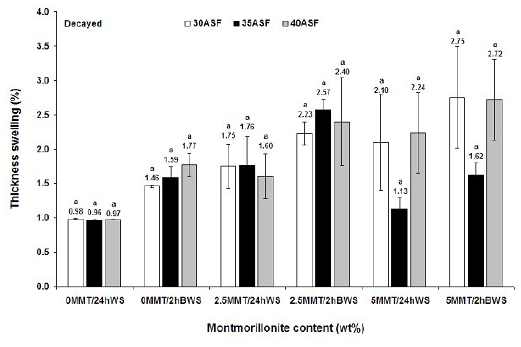
Figure 7. The average and standard error for thickness swelling measurements (2 h boil water soaked and 24 h water soaked) measurements of the decayed composites).